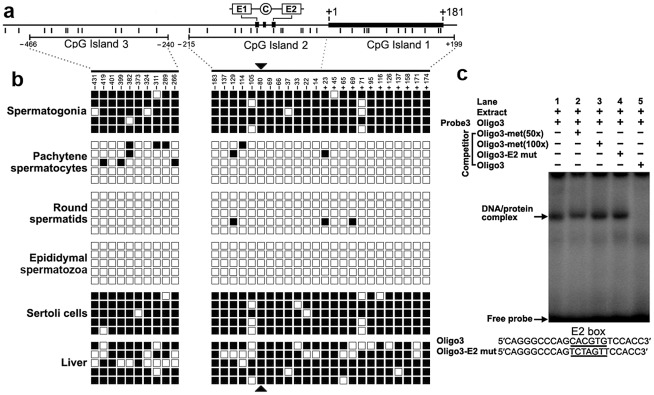
The cytosine methylation profile of the CpG islands in the Miwi promoter, and methylation at the E2 box inhibits USF binding.a), Schematic depiction of the CpG islands and CpG dinucleotides (short verticals) spanning the promoter. The relative positions of the E1, E2 and CCAAT box are indicated. b), Methylation status of each CpG dinucleotide in three CpG islands in various cell types of testis and liver. The spermatogonia, pachytene spermatocytes, round spermatids, epididymal spermatozoa and Sertoli cells were isolated from adult testis by flow cytometry. Bisulfite-treated genomic DNA was amplified and cloned into T-easy vector. Five independent clones from each sample were sequenced. Each row represents the sequence of an individual clone, whereas, each column depicts the position of each CpG site relative to the potential transcription start site. Open squares indicate unmethylated CpG sites; filled squares indicate methylated CpG sites; black triangles represent CpG site in the E2 box. c), The CpG methylation at the E2 box inhibits USF binding. The oligo3 corresponding to −92/−71 was γ-32P-ATP labeled and incubated with 5 µg of nuclear extract prepared from mouse testis in the absence or presence of various competitor DNA, as indicated on the top of the gel image. Nuclear extracts were incubated with labeled oligo3 in the absence (lane 1) or in the presence of various DNA competitors: 50-fold or 100-fold excess methylated oligo3 (lanes 2,3), mutant oligo3 (lane 4) or non-labeled oligo3 (lane 5). The specific DNA/protein complexes were indicated by arrows. The sequences of oligo3 and mutant competitor are shown under the panel.